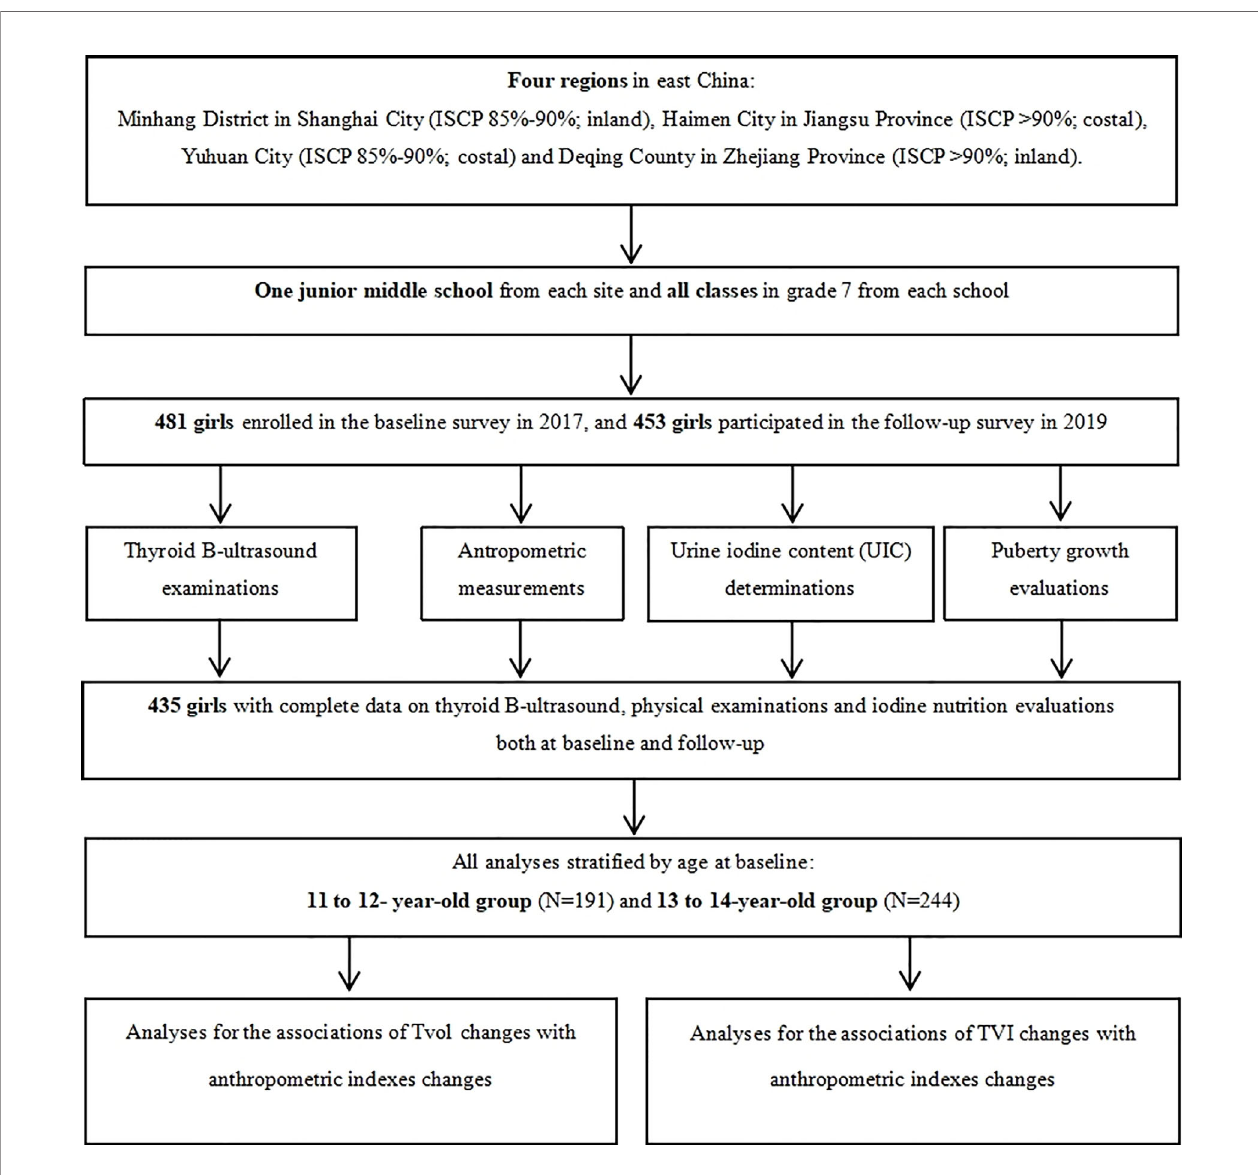
FIGURE 1 | A fl ow chart for the